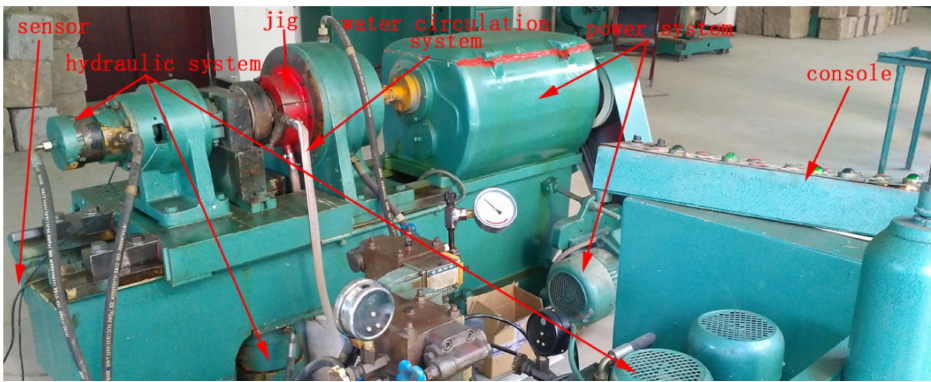
Figure 6. High-speed bearing testing machine.